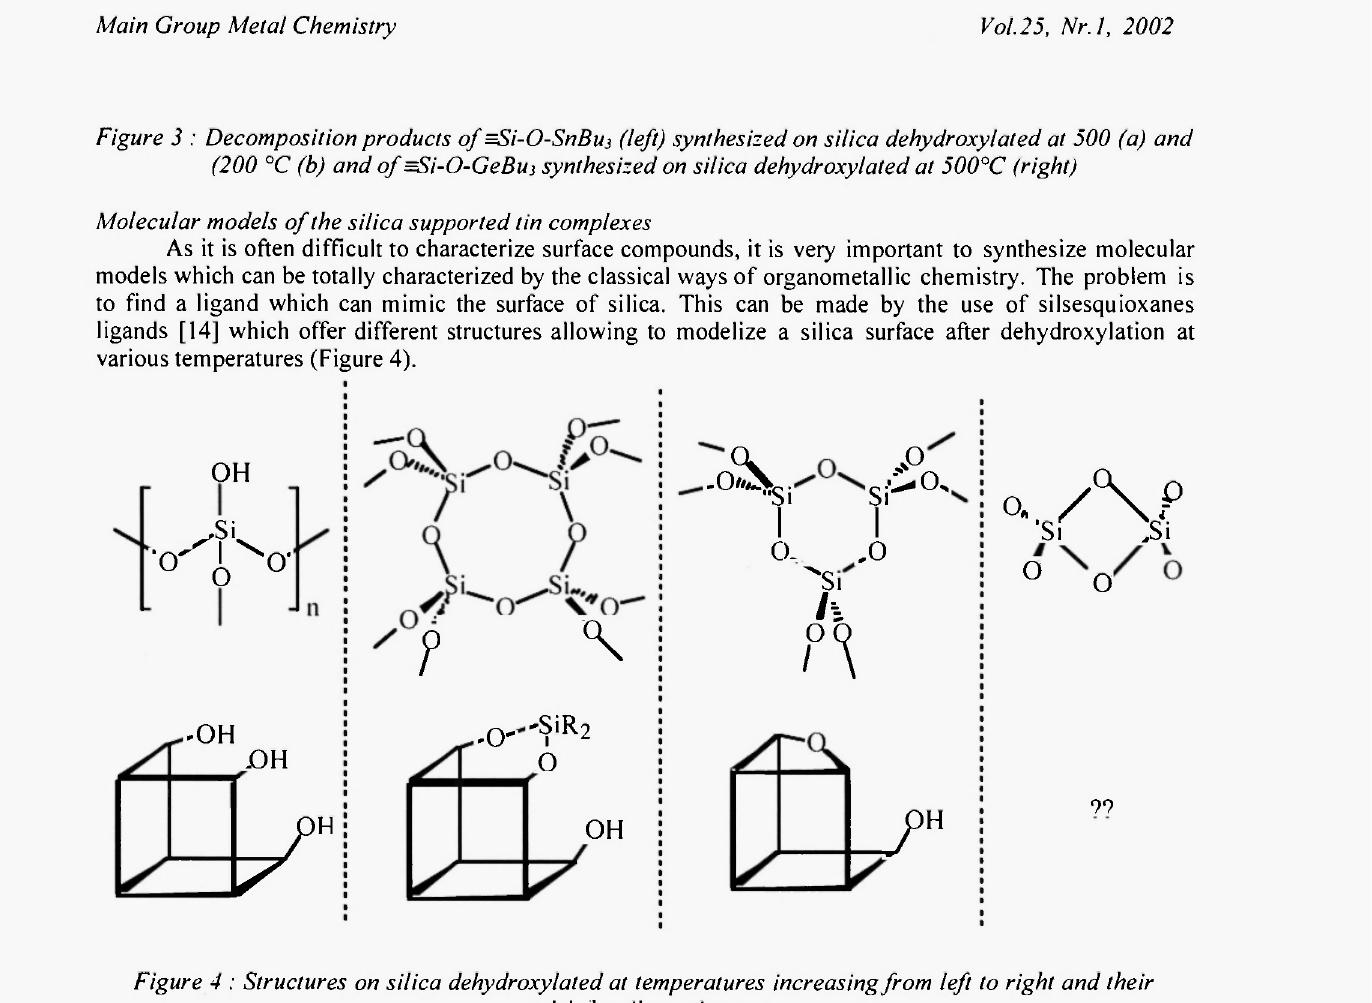
Figure 4 : Structures on silica dehydroxylated at temperatures increasing from left to right and their models by